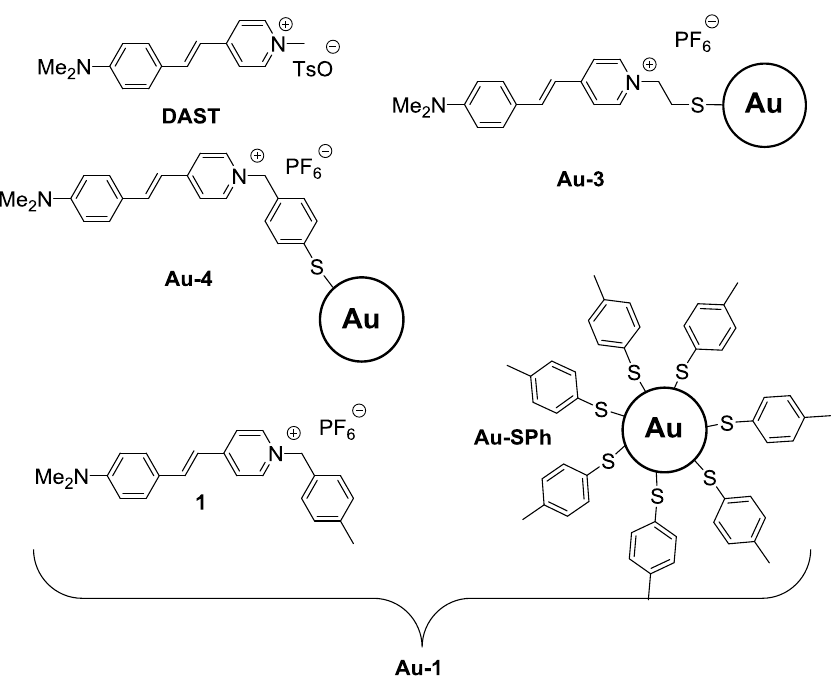
Figure 4. Structures of Au-3 and Au-4 functionalized gold nanoparticles (AuNPs) ( top ) and composition of the Au-1 sample ( bottom ).